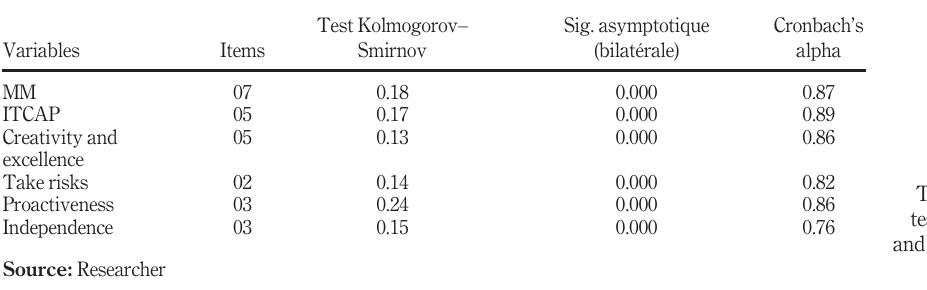
Table 2. The results of